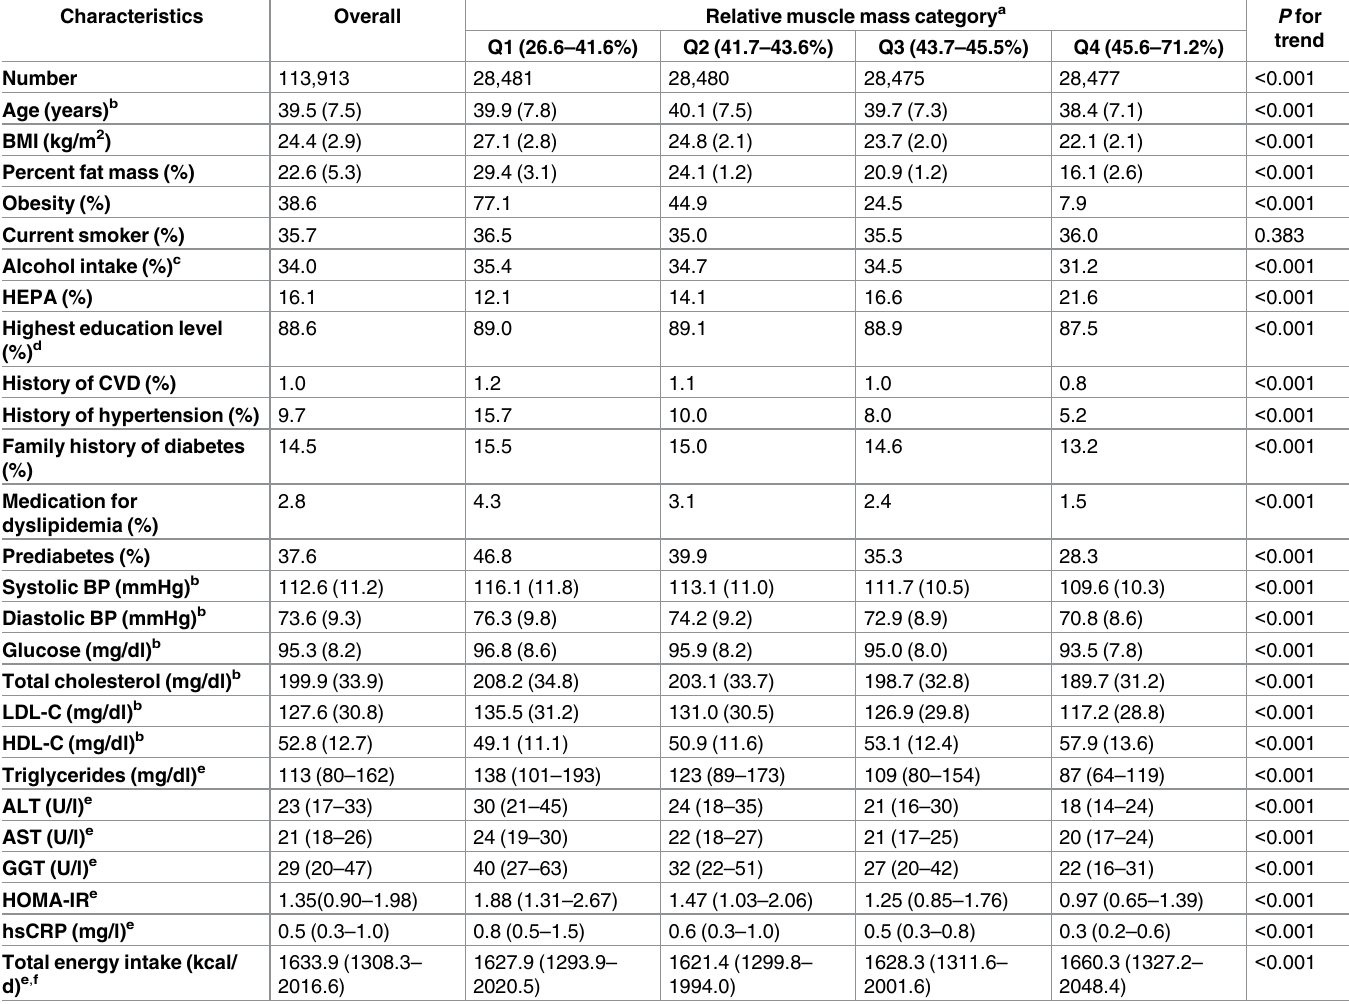
Table 1. Baseline characteristics: Relative muscle mass of male